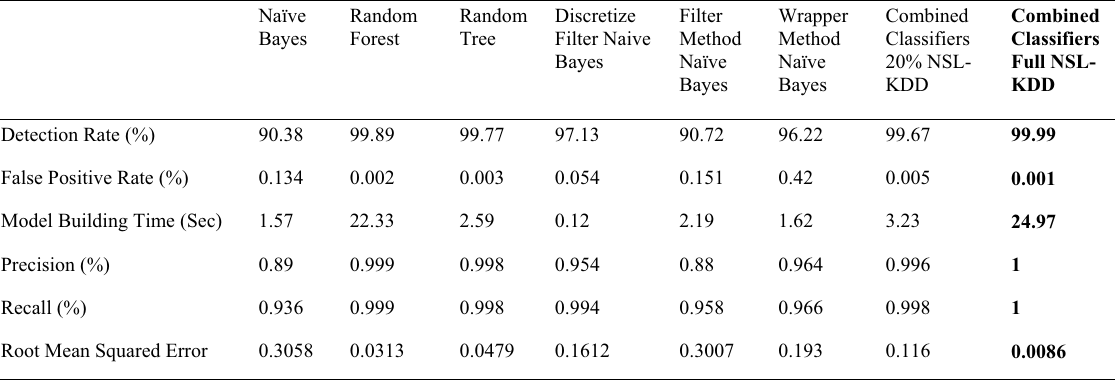
Table 4. Detection Accuracy